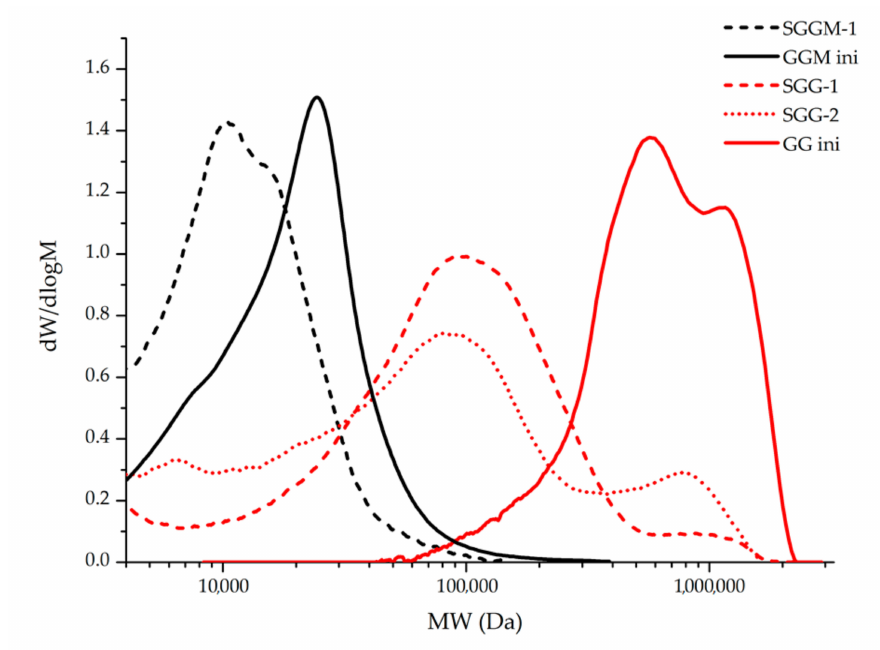
Figure 2. Molecular weight distributions for the initial and sulfated polysaccharides